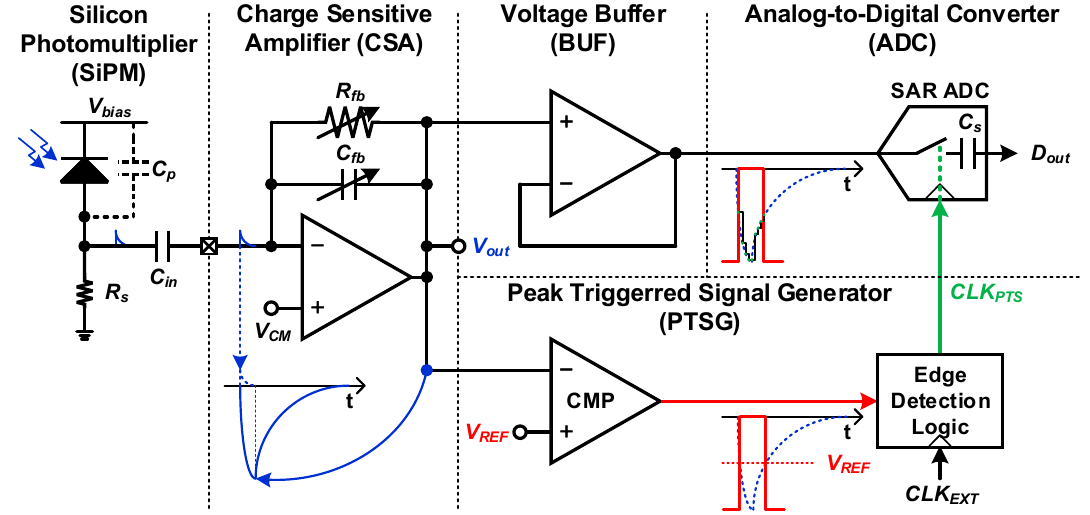
Figure 3. Architecture and operation of the proposed power efficient radiation sensor interface.